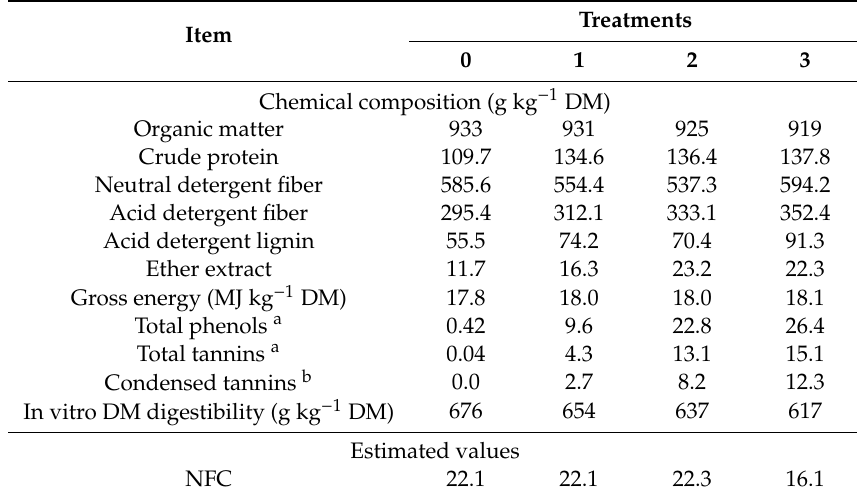
Table 3. Chemical composition of experimental